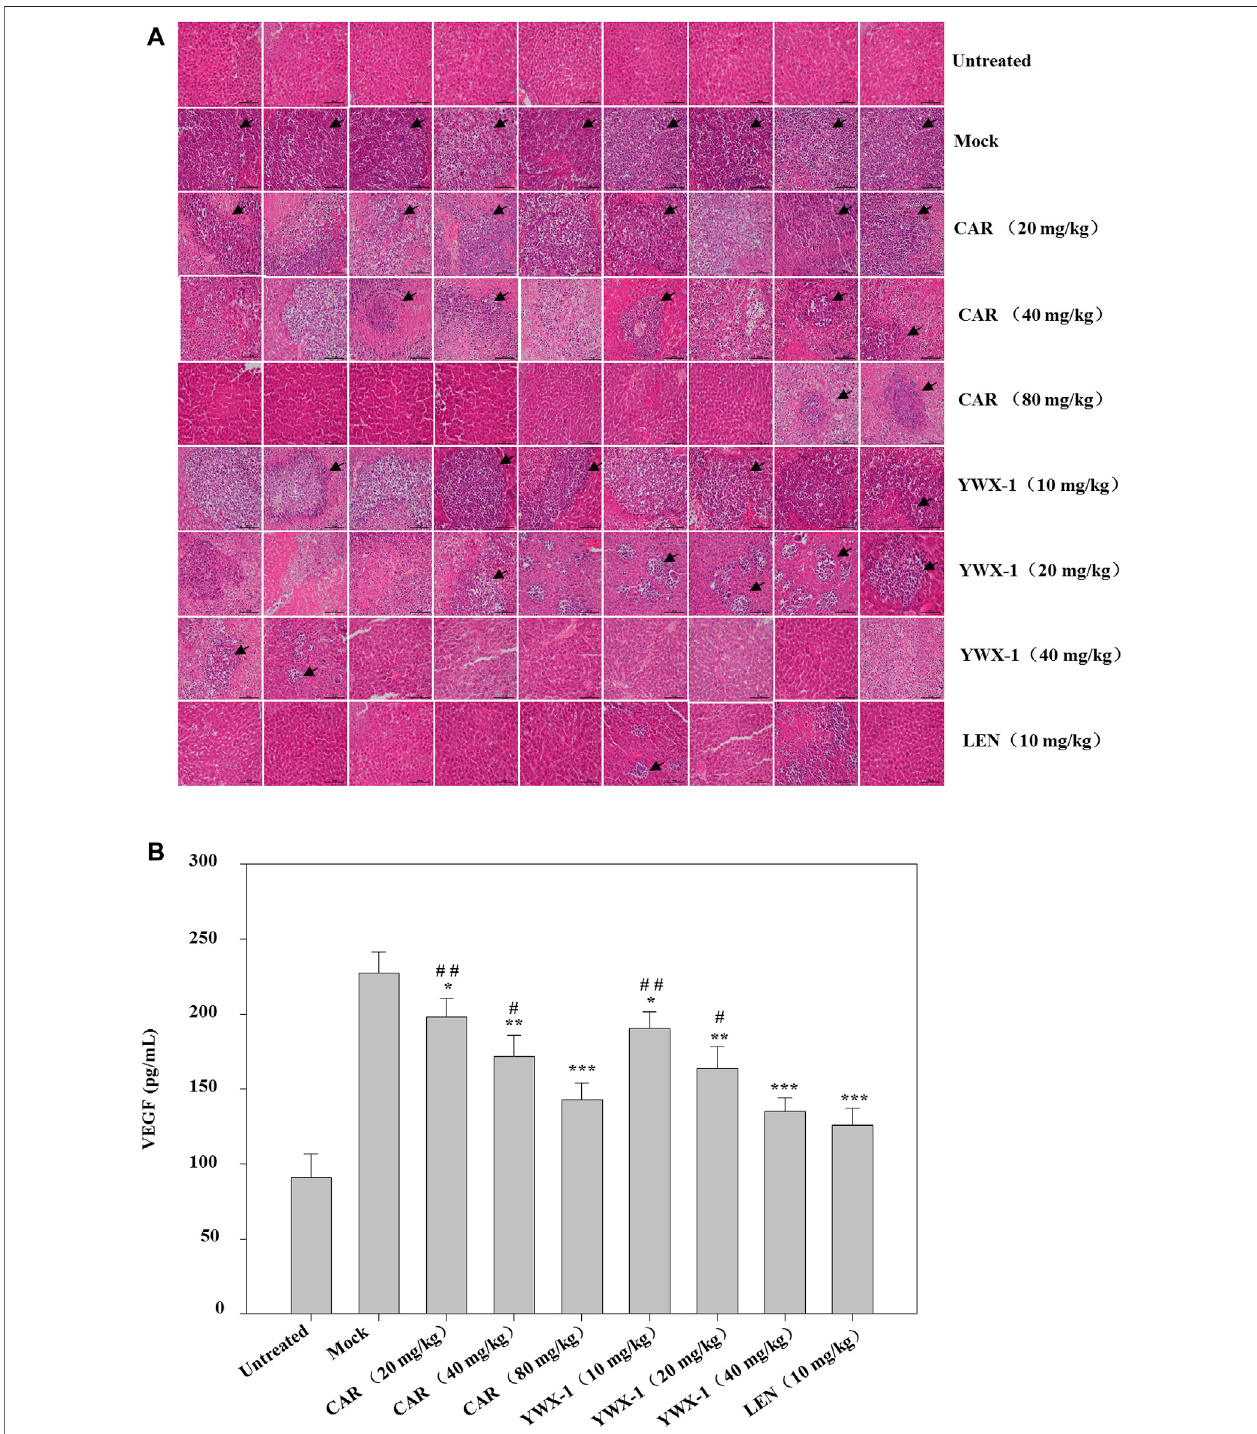
FIGURE 12 | Effect of carrimycin (CAR) and monomeric isovalerylspiramycin I (YWX-1) on the histopathology and VEGF secretion in an orthotopic liver transplantationmodel. (A) TumorsectionswerestainedwithH&E.Histologicalalterationsareindicatedbyarrows.(scalebar,100 μ m). (B) TheconcentrationofVEGFin mice serum was detected by ELISA analysis. Data were presented as the mean ± standard deviation of three independent experiments (n=3). * p < 0.05, ** p < 0.01, *** p < 0.001, compared with the mock group; # p < 0.05, ## p < 0.01, ### p < 0.001 compared with the positive control drug lenvatinib (LEN) 10 mg/kg group.